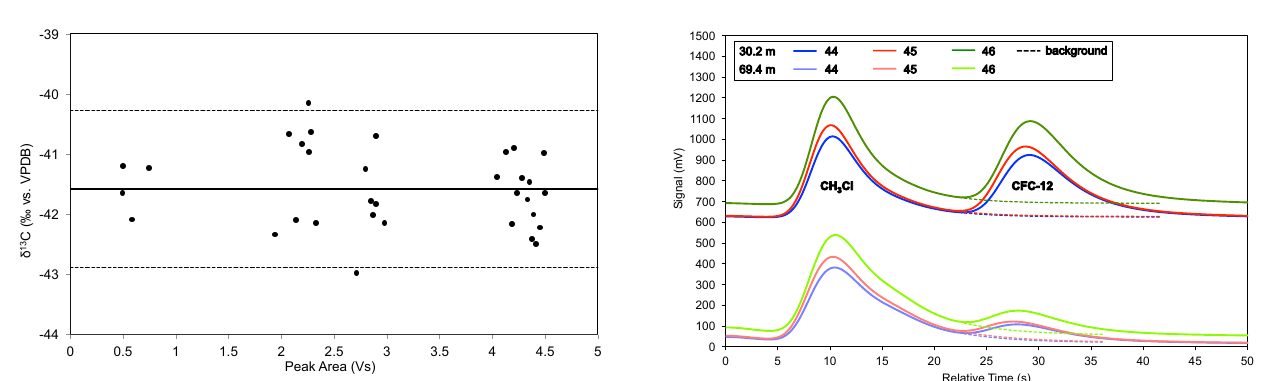
Fig. 2. Chromatograms of CH 3 Cl and CFC-12 detected as ions of CO 2 at m/z 44, 45, and 46 signals (mV) from 30.2 m (upper traces) and 69.4 m (lower traces) depth samples, showing sloping back- ground calculation (dashed). Traces have been aligned through a + 10 s time shift to the 30.2 m sample; additionally, the 30.2 m traces have been offset by 600 mV for presentation